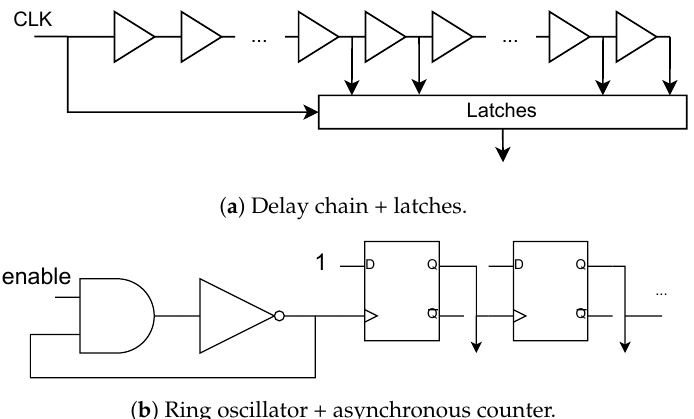
Figure 5. Combinatorial logic delay